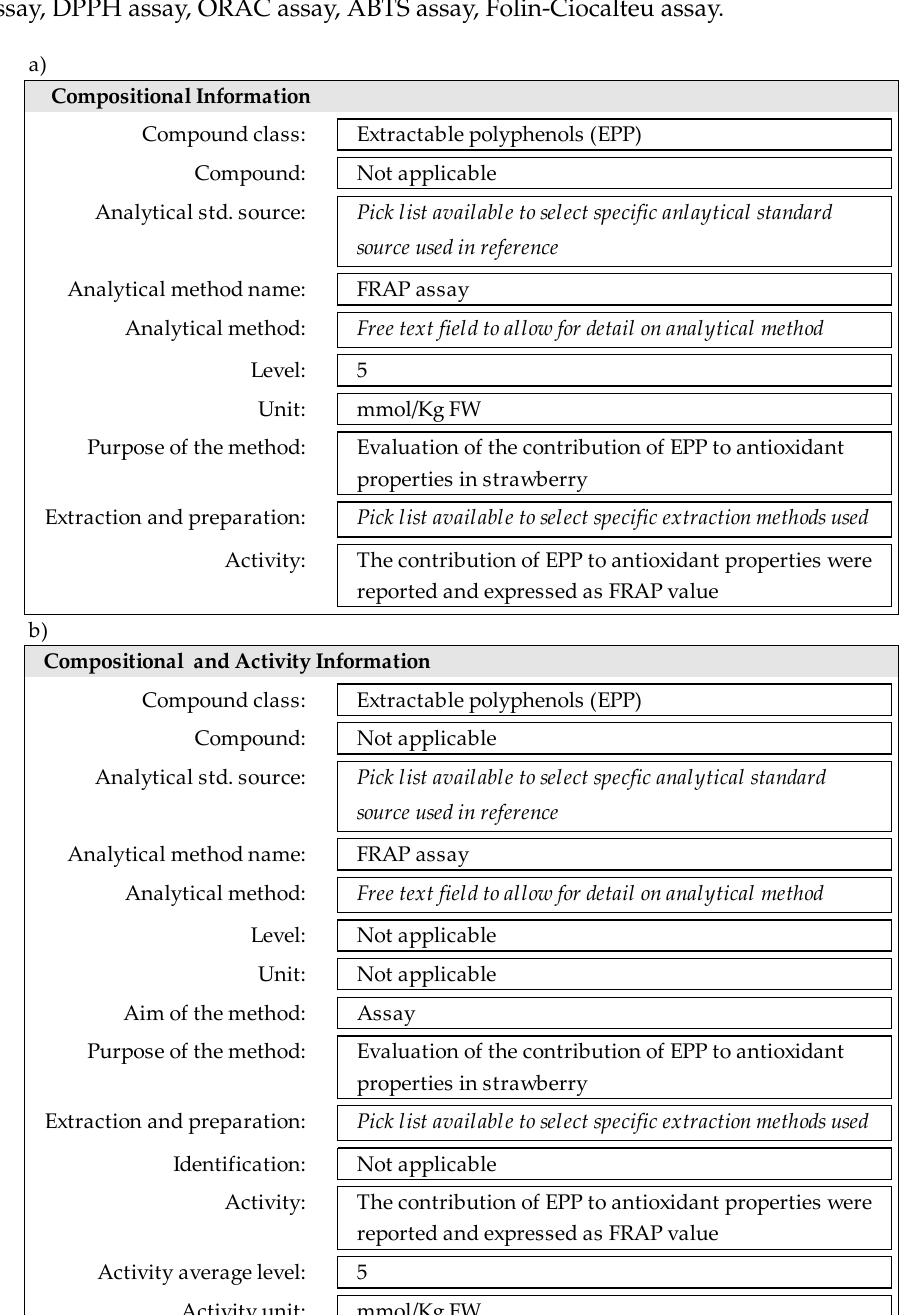
Figure 2. ( a ) Composition information section of eBASIS input form for data entry for EPP; ( b ) proposed model for input form for EPP, in fresh weight (FW) material, using Ferric Reducing Antioxidant Power (FRAP) assay